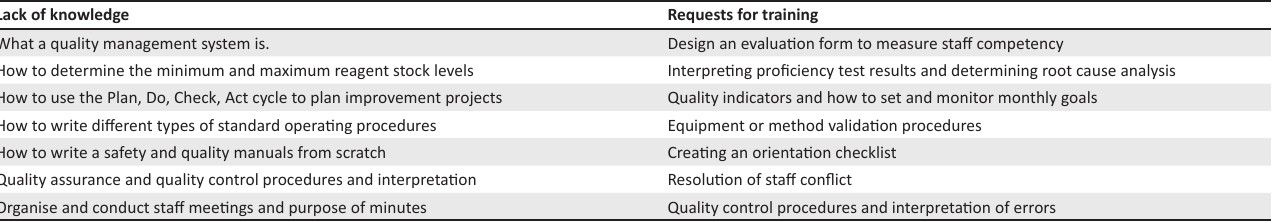
TABLE 4. Examples of staff reported knowledge gaps and requests for training (2017). Lack of